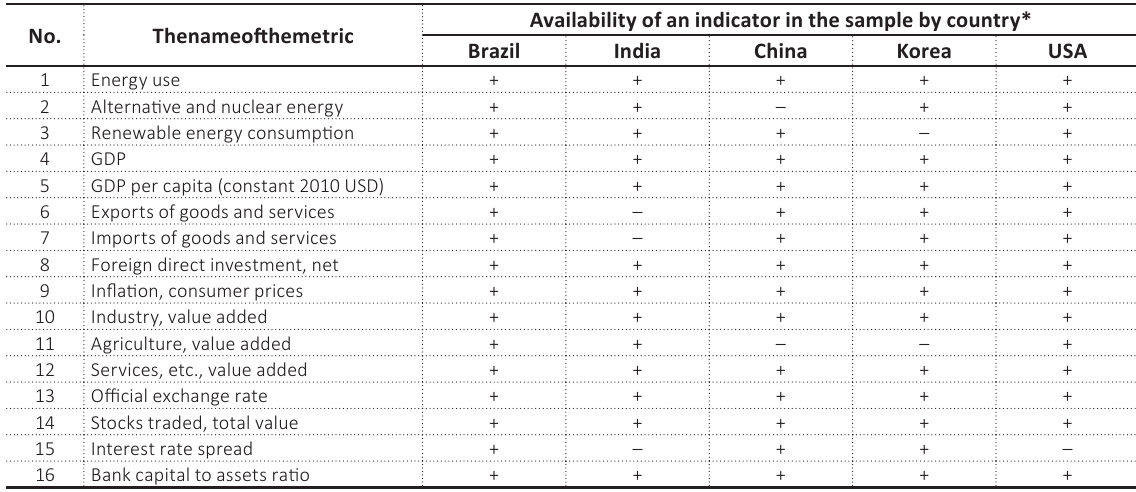
Table 3. List of indicators for forecasting the countries’ economic development